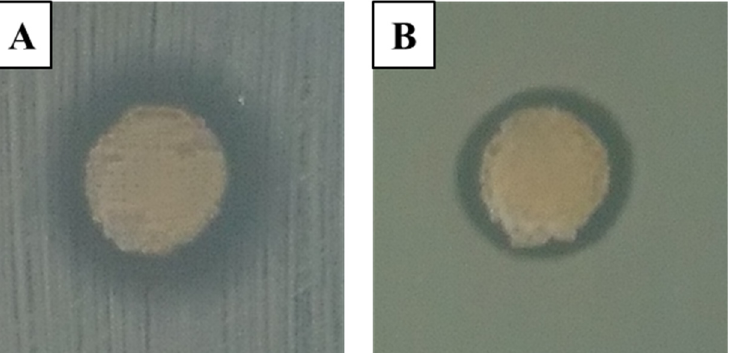
Figure 6. Kirby–Bauer antimicrobial activity assay against multidrug-resistant strains of S. aureus ( A ) and P. aeruginosa ( B ).